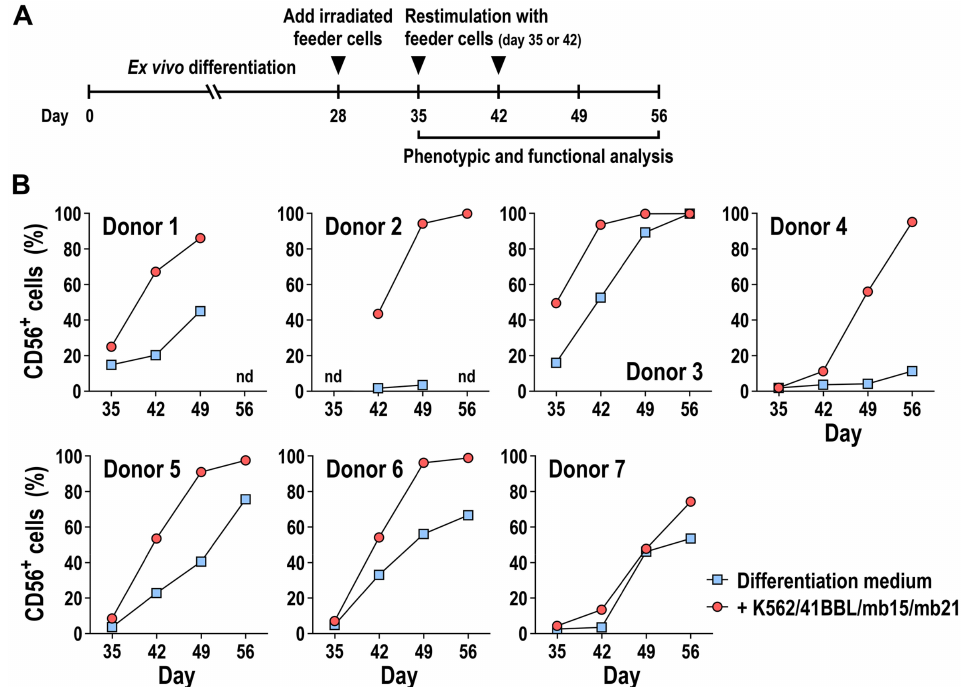
Figure 6. Ex vivo NK cell generation from CD34 + progenitors in the presence of gene-modified K562 cells. ( A ) Schematic representation of the procedure used for ex vivo generation of NK cells from mobilized PB-CD34 + HSCs with gene-modified K562 feeder cells. PB-CD34 + cells were first cultured for four weeks in cytokine-containing medium following the protocol described in Figure 1A. On day 28, 2 × 10 6 cells from the di ff erentiating cell pool were mixed with 1 × 10 6 lethally irradiated K562 / 41BBL / mb15 / mb21 feeder cells. Starting after one week of co-culture (day 35), the development of CD56 + NK cells was analyzed once weekly by flow cytometry. Ex-vivo-generated CD56 + NK cells were restimulated with K562 / 41BBL / mb15 / mb21 cells, as described in Materials and Methods. ( B ) Generation of CD56 + NK cells from PB-CD34 + cells following stimulation with K562 / 41BBL / mb15 / mb21 feeder cells ( n = 7 individual donors). For comparison, CD34 + cells cultured in regular di ff erentiation medium without feeder cells were included (data for these controls are the same as shown in Figure 3A). Note: nd = not